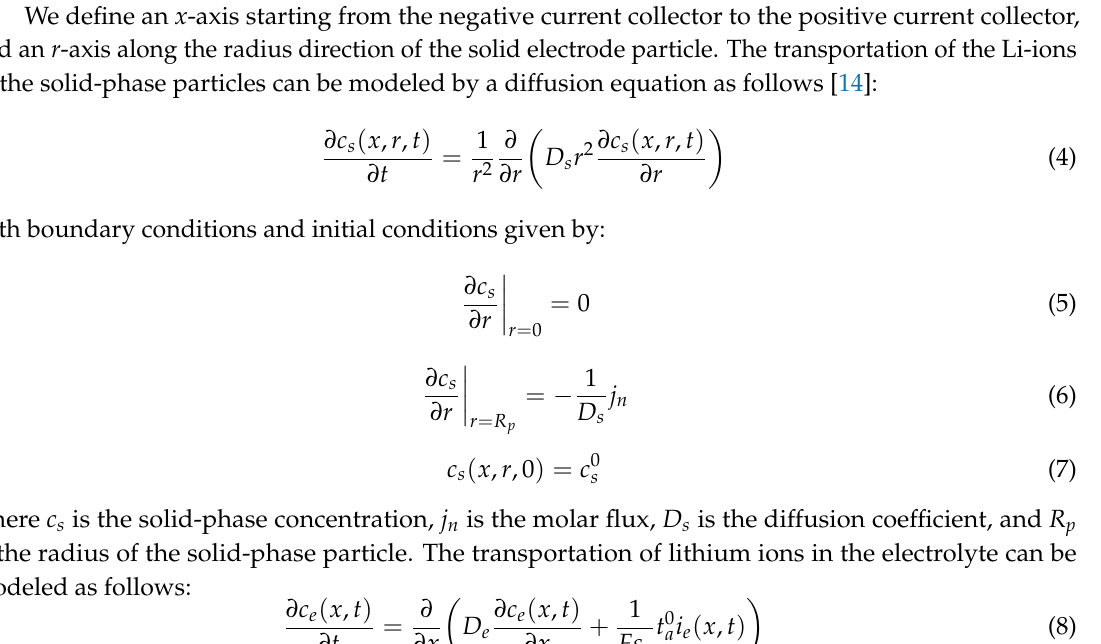
Figure 3. Dualfoil battery electrochemical model.